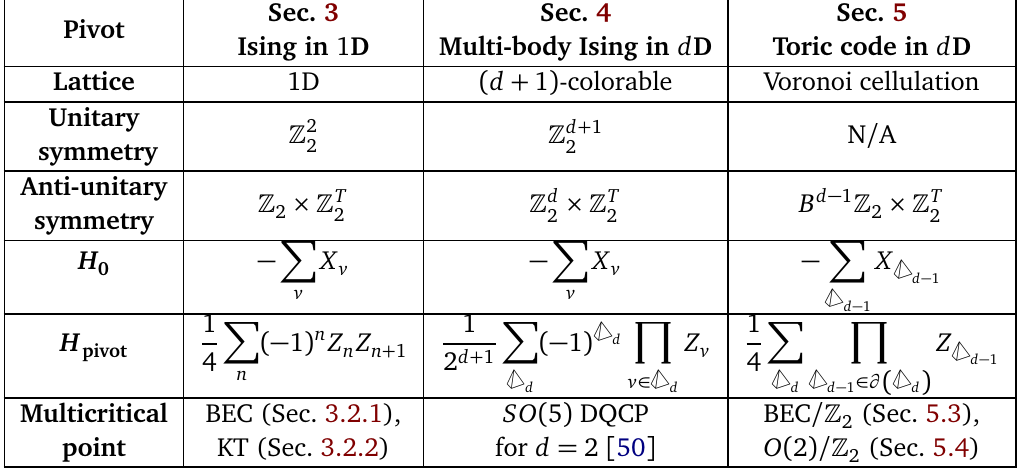
Table 1: Summary of symmetries and the corresponding pivot Hamiltonians H Starting with the product state Hamiltonian H